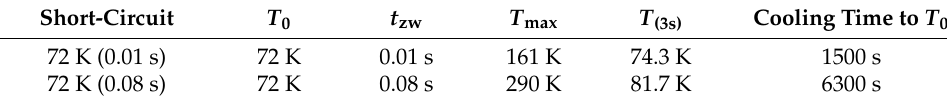
Table 7. Maximum and final temperature of the limiter acc. Figure